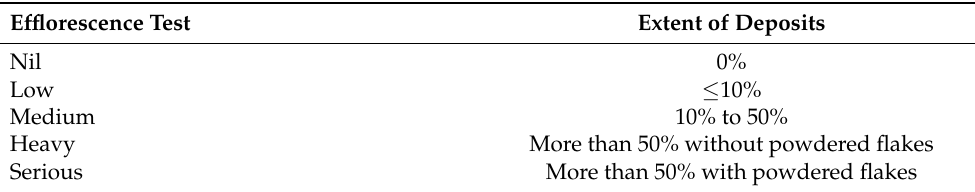
Table 4. Percentage of alkali presence after efflorescence test. Efflorescence Test Extent of